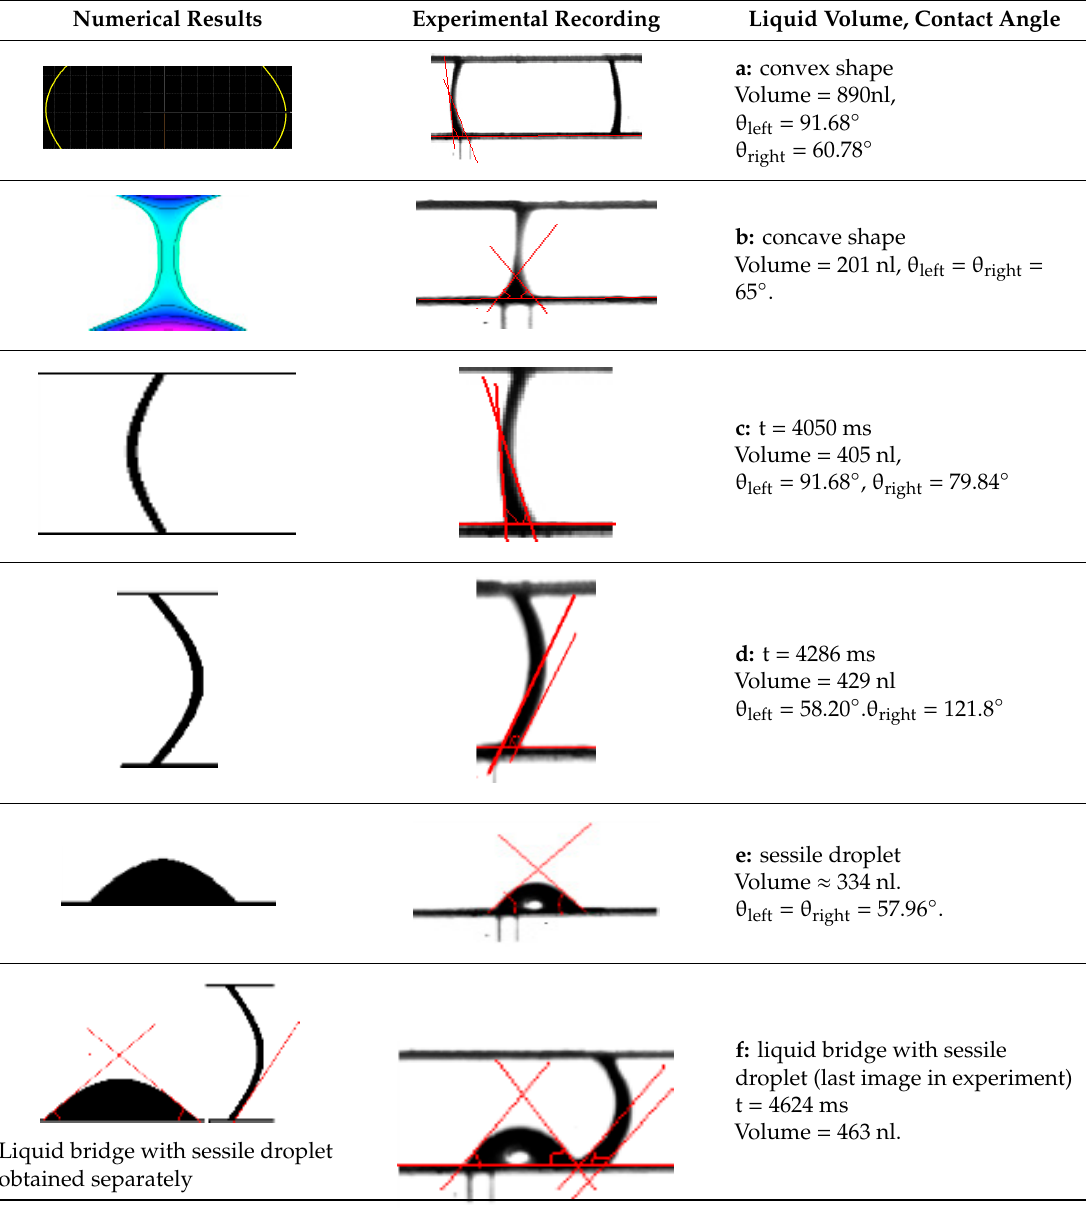
Table 3. Comparison of liquid bridge shapes obtained numerically and experimentally.